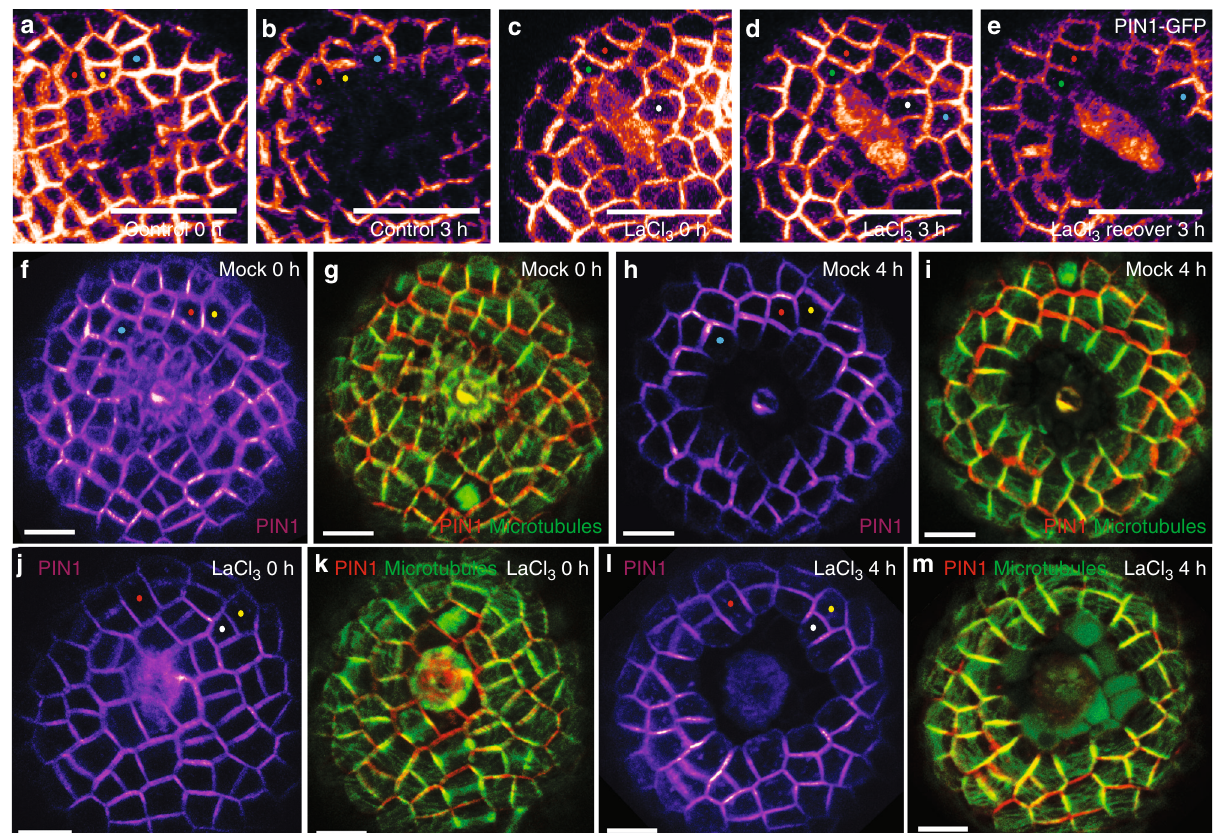
Fig. 2 Mechanical responses of PIN1 and MT after LaCl 3 treatments. a , b PIN1-GFP shows polarized subcellular localization 3 h after local cell ablation with a glass pipette, without pharmacological treatment. c , d PIN1-GFP reorientation was not detected 3 h after cell ablation following 15 min pretreatment with 5 mM LaCl 3 without a subsequent water rinse. e At three additional hours after LaCl 3 washout, PIN1-GFP has reoriented away from the ablation site. a – e LUT is gem in Fiji-ImageJ software. f – m Confocal projections of laser-ablated SAMs expressing pPIN1::PIN1-GFP (magenta in f , h , j , l or red in g , i , k , m ) and pML1::mcherry-MAP4 (green). f , g Mock treated meristem just after ablation. h , i The same meristem as in f and g , 4 h later. j – m Another laser ablated meristem, treated with 5 mM LaCl 3 15 min before ablation and imaged at 0 h after ablation ( j , k ) and 4 h later without a water rinse during incubation ( l , m ). Note difference in PIN1 polarity response comparing h with l although MTs re-oriented circumferentially in both cases (compare i with m ). a – m Similarly colored dots mark the same cells tracked over time. Scale bars: 20 µ m ( a – e ) and 10 µ m ( f – m